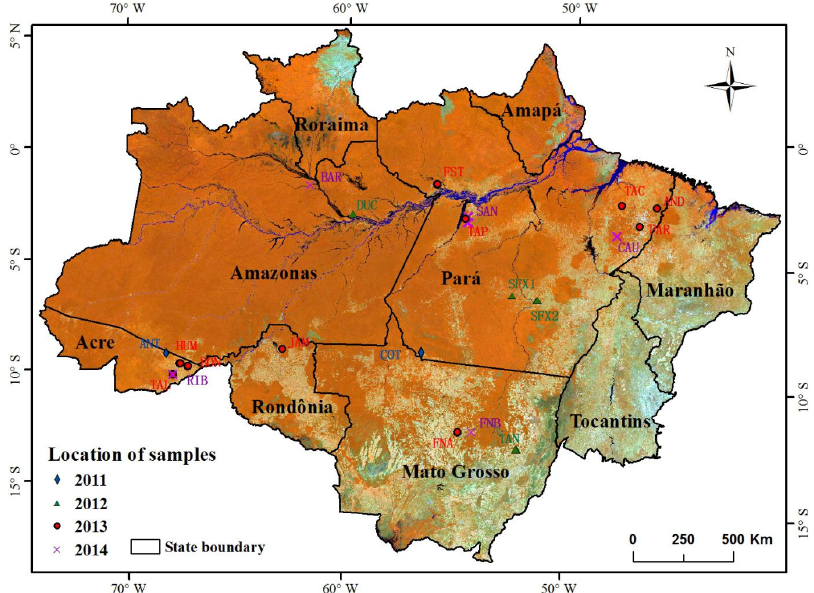
Figure 1. The color composite of the 2017 moderate-resolution imaging spectroradiometer (MODIS) data showing the Amazon basin and light detection and ranging (LiDAR) data sites for different years. Large-scale processes of colonization, deforestation, and forest degradation in the Brazilian Amazon began in the early 1970s, with settlement projects and construction of roads connecting the region with the southern and northeastern portions of the country. Since 1970, deforestation has resulted in more than 0.7 million km 2 of forest loss [61]. There is a significant uncertainty about the amount and spatial distribution of forest aboveground biomass in the Brazilian Amazon, but it is generally above 300 Mg/ha in its central to western portions. Transitional forests in the southern portions of the region have biomass amounts ranging from 100 to 200 Mg/ha [48]. Forest degradation has affected the amount of AGB in Amazonian forests, which calls for cutting edge studies on this topic [5]. 2.2. Datasets Used in this Research In our research, we used two kinds of remotely sensed data, namely airborne LiDAR and MODIS data, as well as ancillary data (annual land cover maps, 2011–2017) (see Table 1). Airborne LiDAR data from 23 sites in five states—Acre, Rondônia, Mato Grosso, Pará, and Amazonas—were acquired for 2011–2014 and downloaded from the repository at Brazilian Agricultural Research Corporation [62]. Among the 23 sites, 18 were the same as those used by Longo et al. [5]. The spatial locations of all sites are illustrated in Figure 1. The airborne LiDAR data for 2011–2014 were acquired at an average of 850–900 m above ground by Geoid Laser Mapping, Ltd., using the ALTM (Airborne Laser Terrain Mapper) Orion M-200. We established a minimum return density of more than four points per square meter for data collection. A detailed description of the LiDAR systems used for surveys can be found in the paper by Longo et al. [5]. The downloaded point cloud data of each site were processed to generate a digital terrain model (DTM) and digital surface model (DSM) with a cell size of 1 × 1 m. The CHM data were obtained by subtracting DTM from DSM.